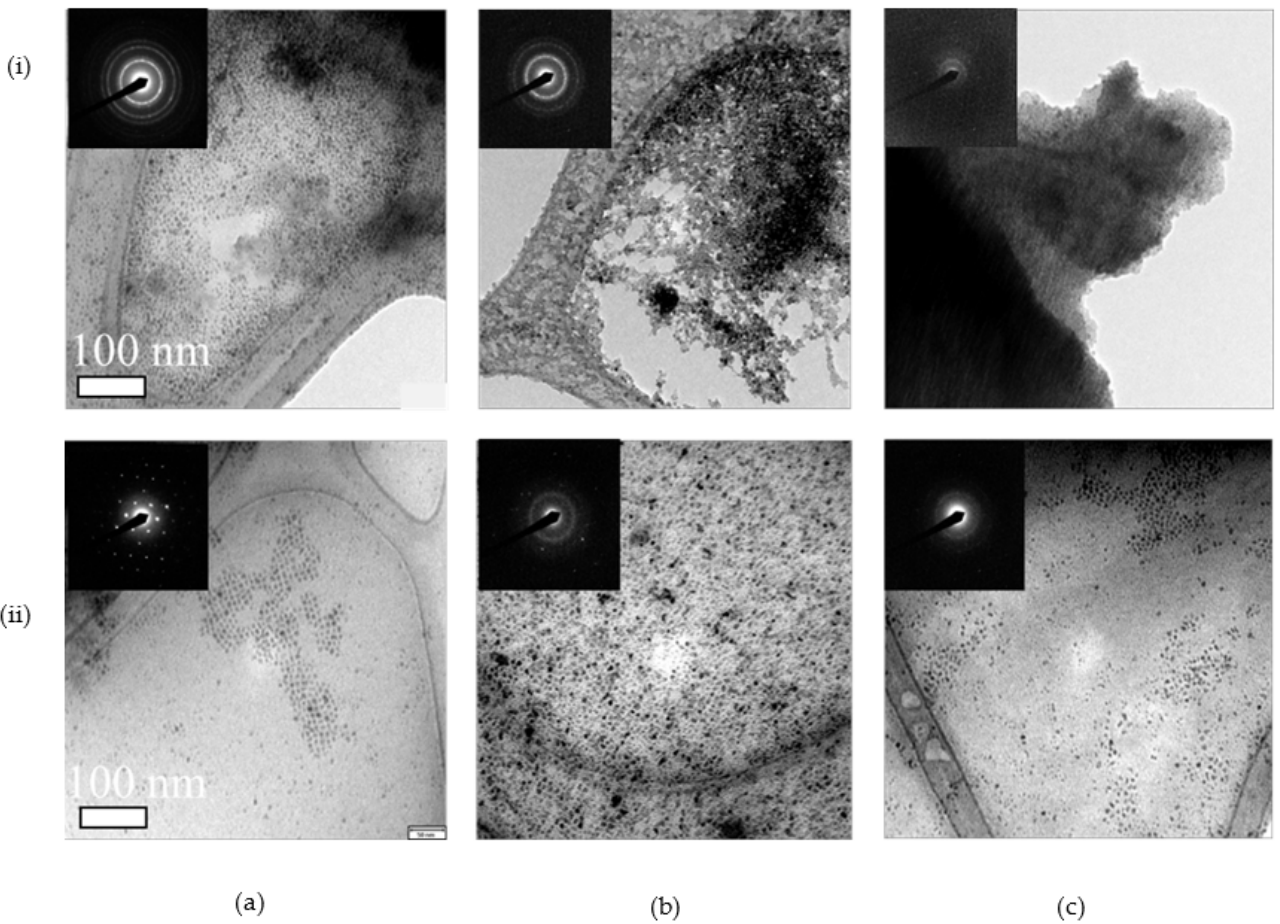
Figure 10. TEM images of ( i ) CeO x and ( ii ) Eu:CeO x nanoparticles generated from TBA preparation route during ion irradiation: ( a ) green, ( b ) 1 × 10 13 cm − 2 , and ( c ) 1 × 10 15 cm − 2 . Respective SAED patterns are displayed in the inset of each micrograph. Scale bars are 100 nm in all micrographs.